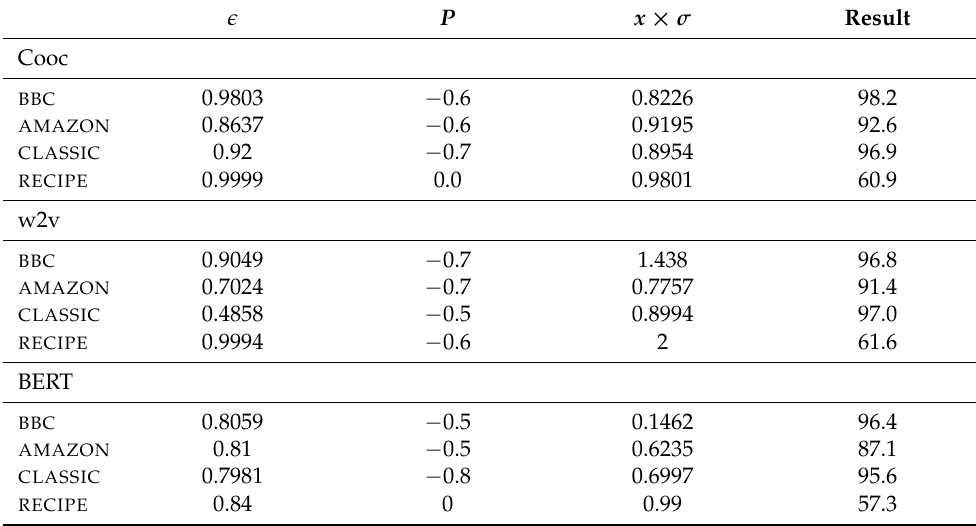
Table A4. Parameters of GTSM obtained by Bayesian